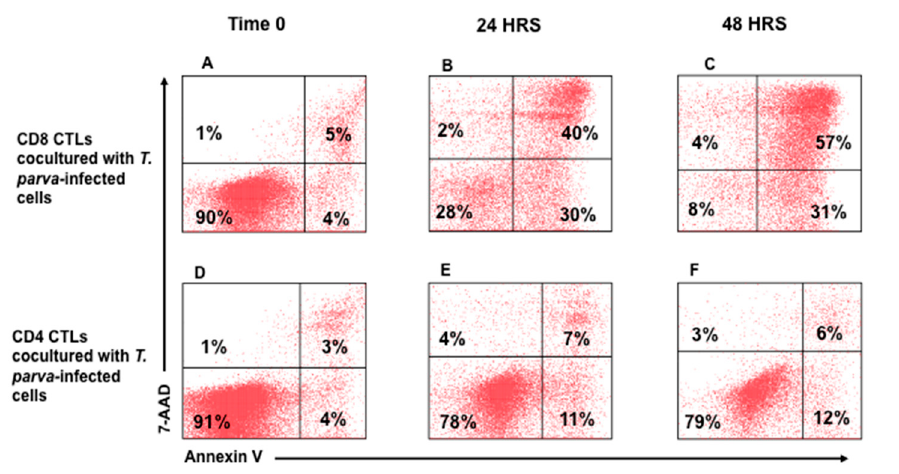
Figure 5. Flow cytometric comparison of CTL activity mediated by T. parva -specific CD4 + and CD8 + T cells. Representative flow cytometric profiles showing the proportion of apoptotic and dead T. parva- infected target cells present in preparations incubated for 0, 24, or 48 h with T. parva -specific, CD8 + ( A – C ) or CD4 + ( D – F ) T cells. Comparison of the lower left quadrants of the target cells incubated with CD4 or CD8 T cells show a clear reduction in viable target cells in the presence of sepa- rated CD8 T cells. This documents that the death of the target cells is attributable to a lethal hit mediated by CD8 T cells.